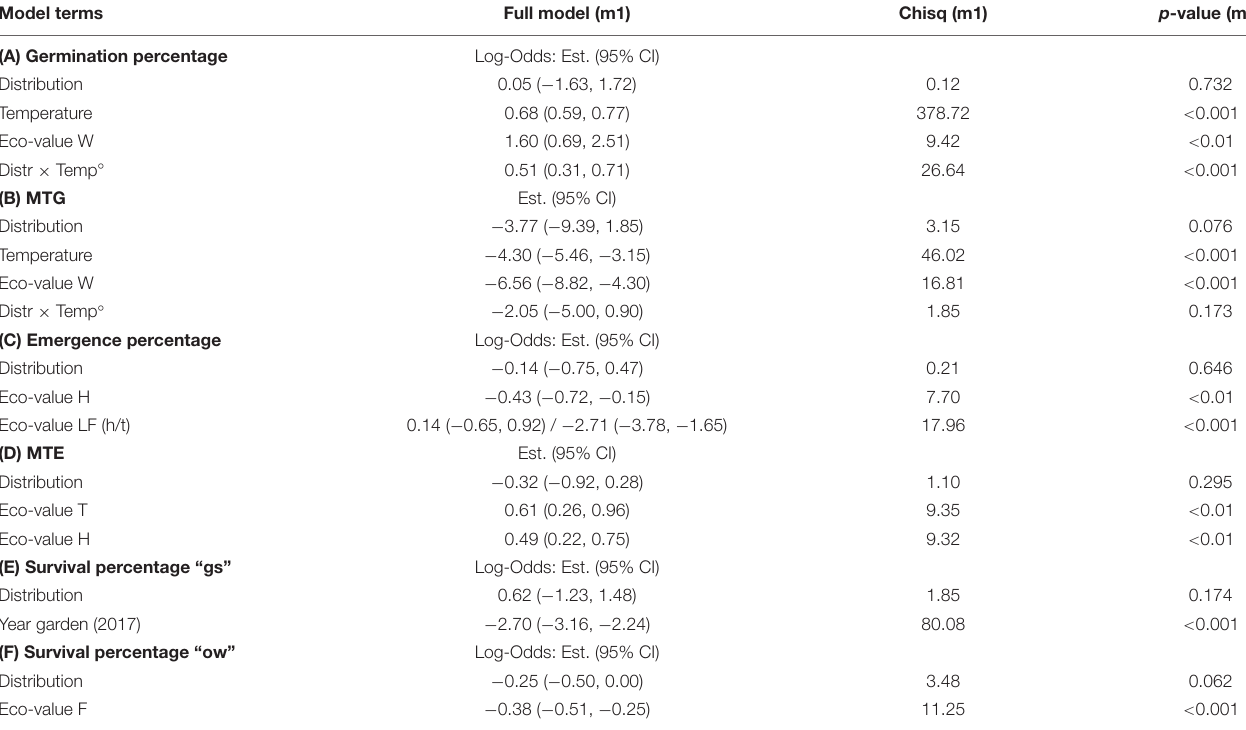
TABLE 2 | Results of mixed models of studied recruitment traits (A) germination percentage, (B) mean time to germination (MTG), (C) emergence percentage, (D) mean time to emergence (MTE), (E) survival percentage after the growing season “gs,” and (F) overwinter survival percentage (“ow”), in response to distribution, temperature conditions, the interaction term, and ecological indicator values (see Table 1 ) that were found to be significant when individually added to the